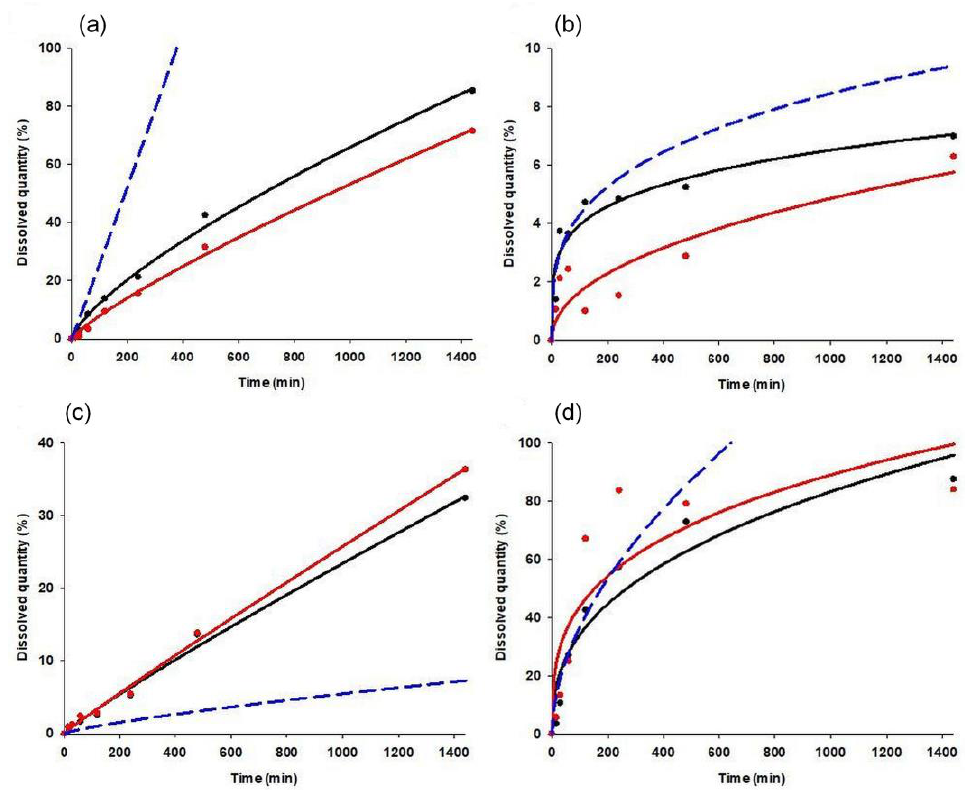
Figure 7. Observed and predicted dissolution curves of case 43 ( a ), case 36 ( b ), case 24 ( c ) and case 7 ( d ). Black dots: observed data points; black line: fitted model on observed data; red dots: predicted data points; red line: fitted model on predicted data points; blue line: predicted model.